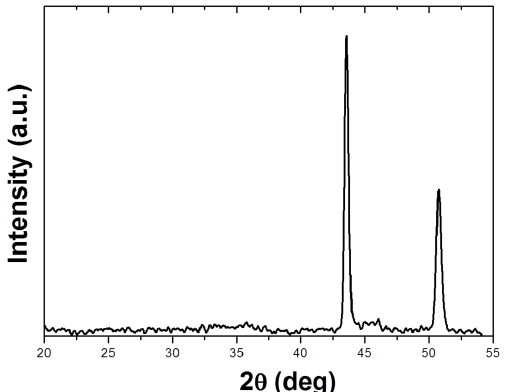
Figure 7. Structural XRD characterization of a 100 nm thick SDP-Y 2 O 3 coating by GADDS (2D detector) showing only the peaks of the SS substrate.